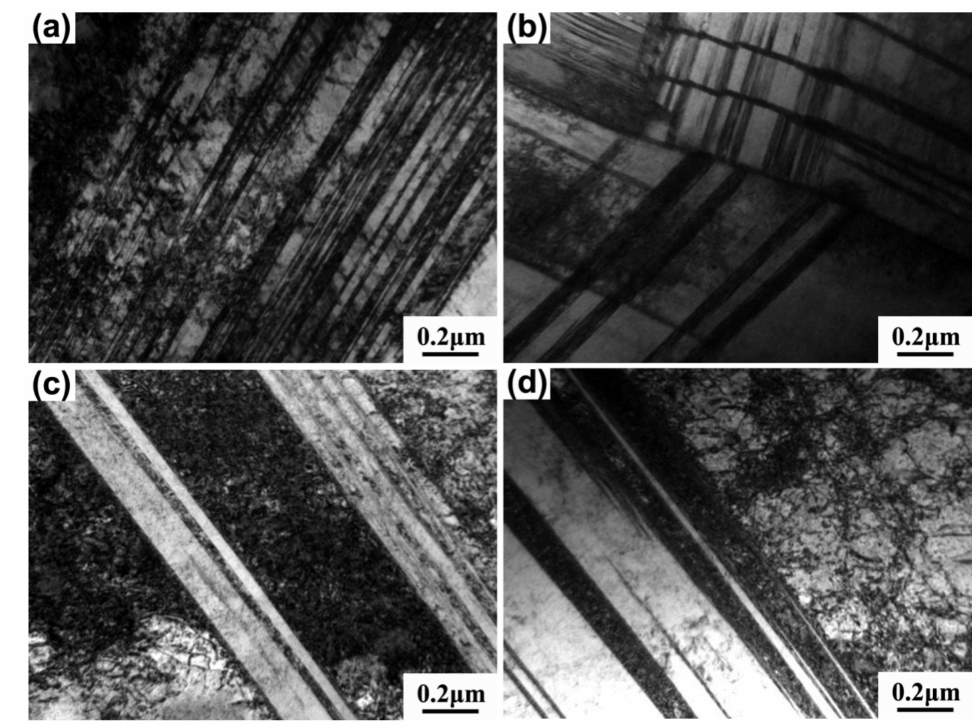
Figure 4. TEM images of 80Mn11 ( a , b ) and 130Mn11 ( c , d ) steels at a tensile strain of